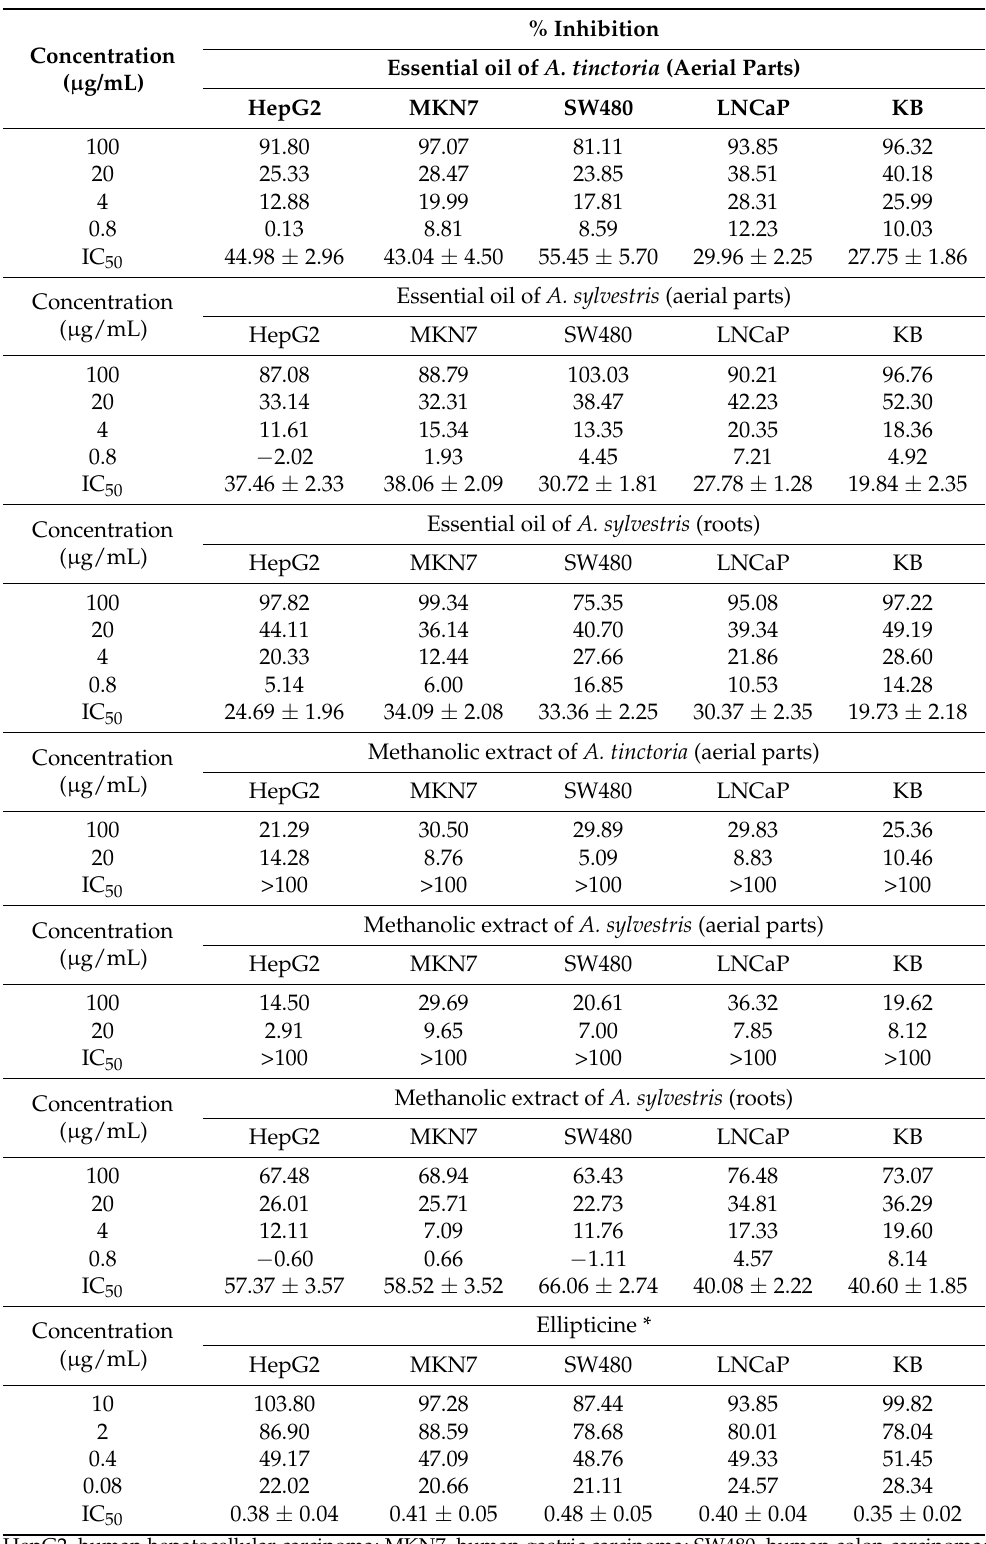
Table 7. Anticancer activity of essential oils and methanolic extracts of A. tinctoria and A. sylvestris .